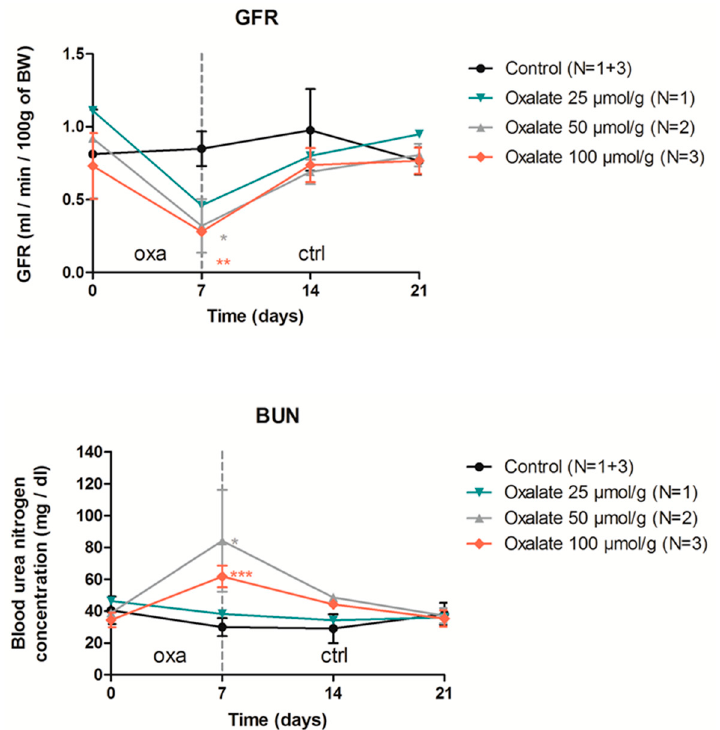
Figure A1. Impact of one week of OXA diet (used at 3 different concentrations) followed by 2 weeks of control diet on rat GFR (mL/min/100 g of BW) and blood urea nitrogen. Results are expressed as mean ± SD; ns p > 0.05; * p ≤ 0.05; ** p ≤ 0.01; *** p ≤ 0.001, versus control.